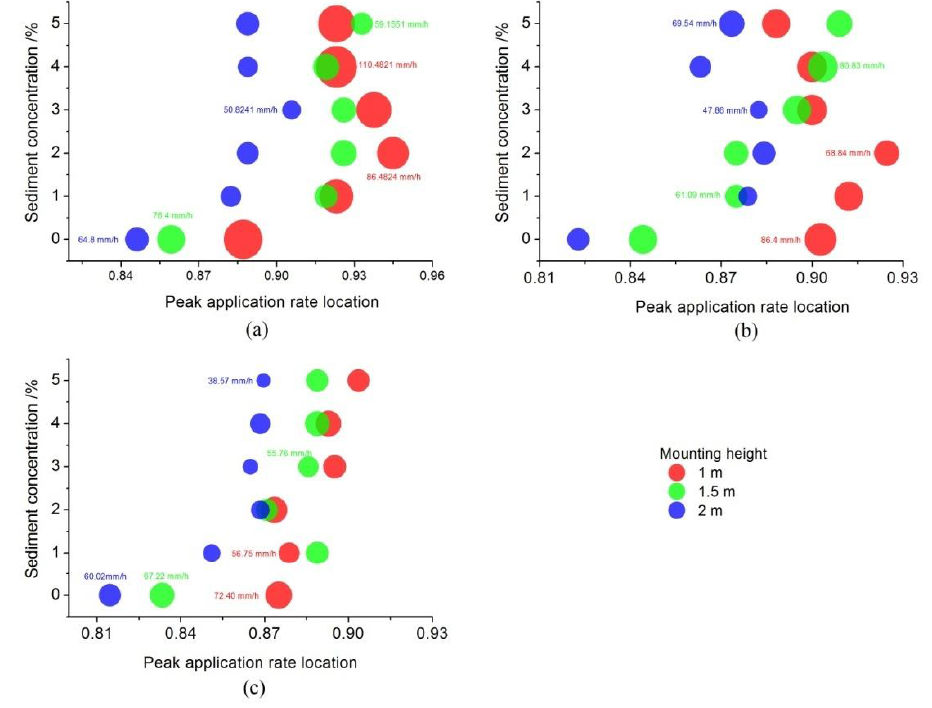
Figure 5. Migration of peak application rate with different sediment concentrations. Note: ( a ) 100kPa, ( b ) 150kPa, ( c ) 200kPa.